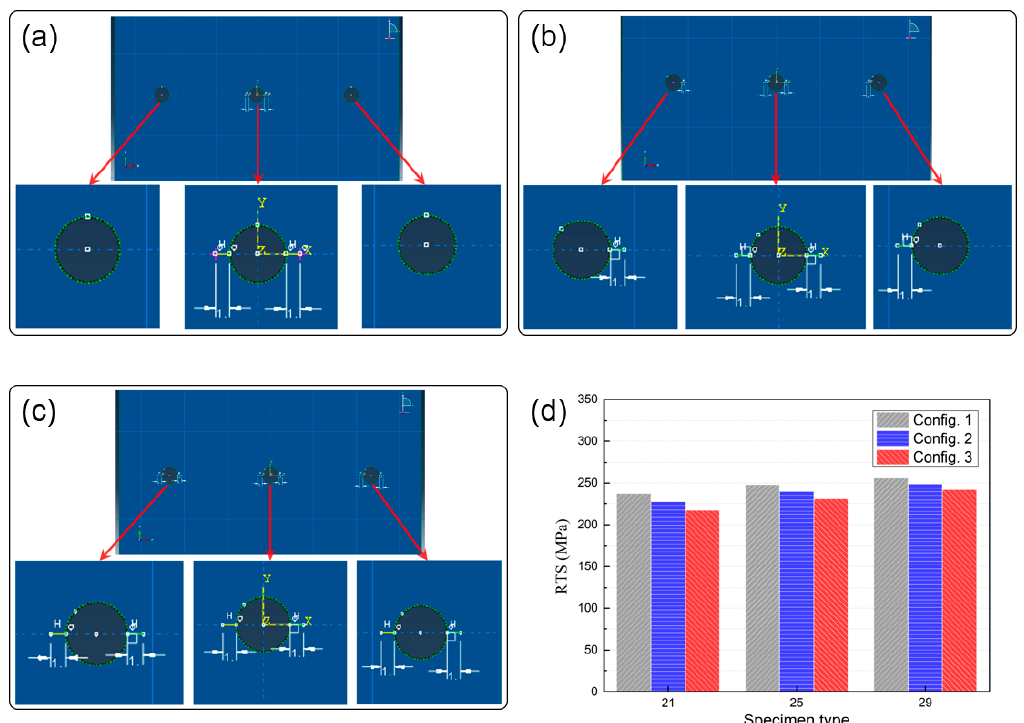
Figure 7. ( a ) Detail of Config. 1, ( b ) detail of Config. 2, ( c ) detail of Config. 3, and ( d ) RTS of different configurations calculated based on the Net section yield criterion. RTS of different MSD specimens increase with the increase of L and configuration 3 is more likely to fail than the others.